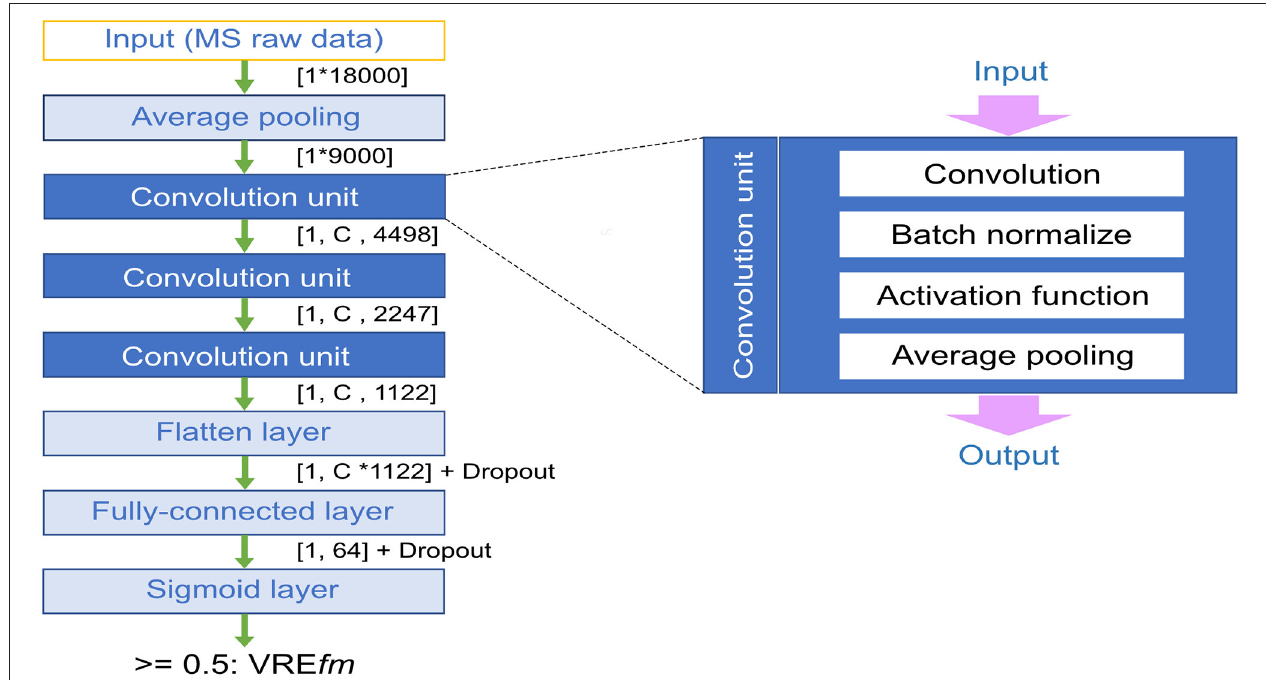
FIGURE 1 | Illustration of convolutional neural network (CNN) model architecture. C denotes different channels, and the dropout rate was 0.5.